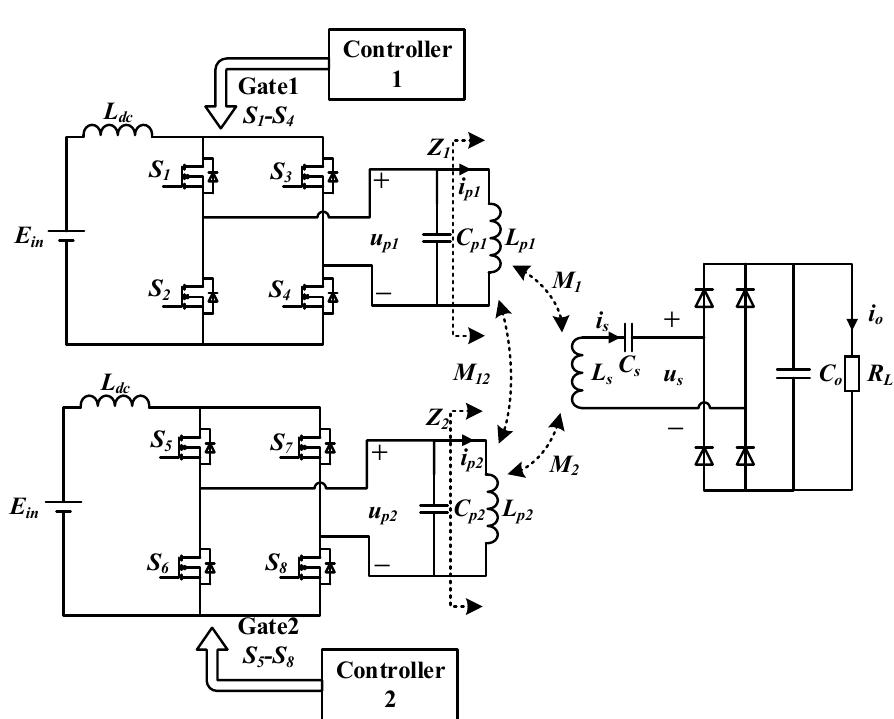
Figure 2. Equivalent circuit model of DEU-WPT system.